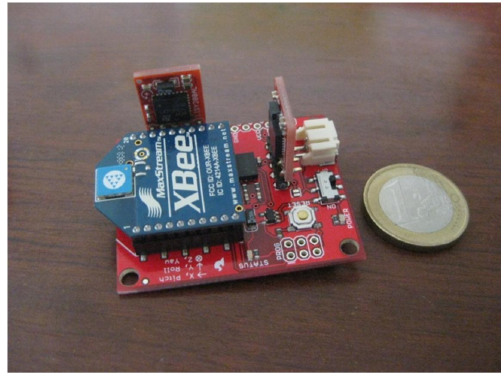
Figure 11. IMU used to validate the results.